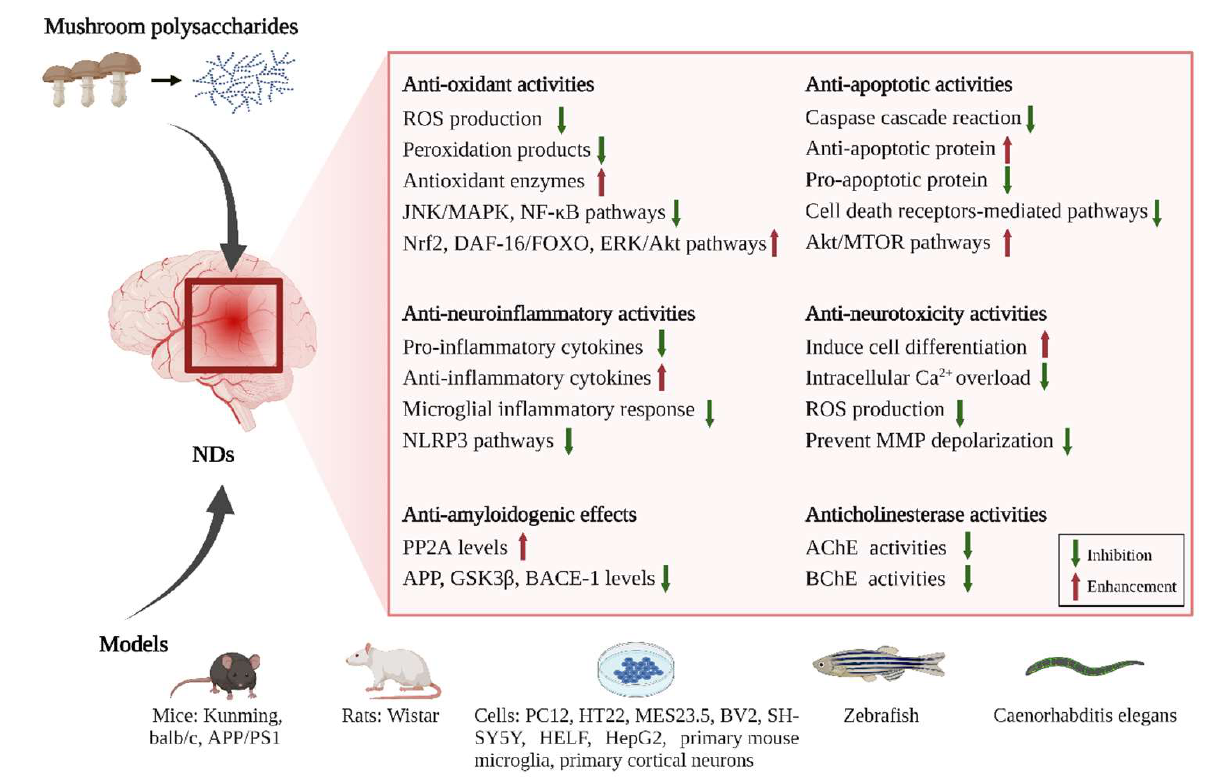
Figure 2. The neuroprotective mechanisms of mushroom polysaccharides involved in NDs. Table 1. Effects of mushroom polysaccharides on NDs.